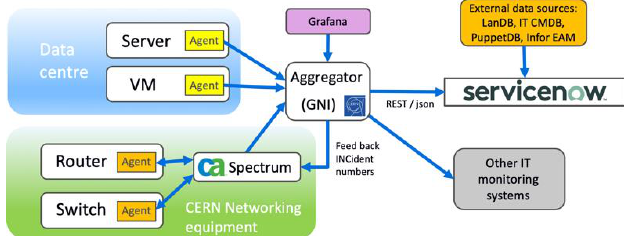
Fig. 5. Flow of information going through GNI and into